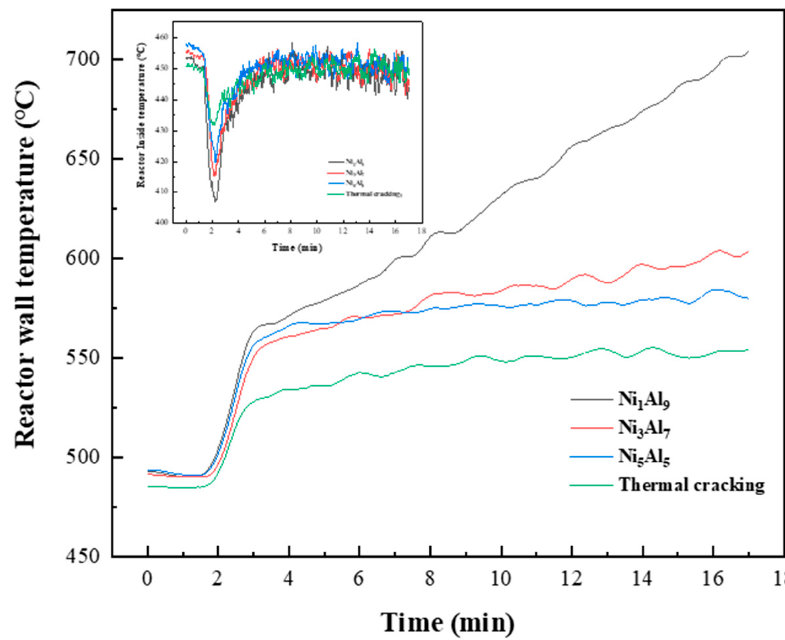
Figure 11. Reactor inside and wall temperature profiles during methylcyclohexane (MCH) crack- ing.